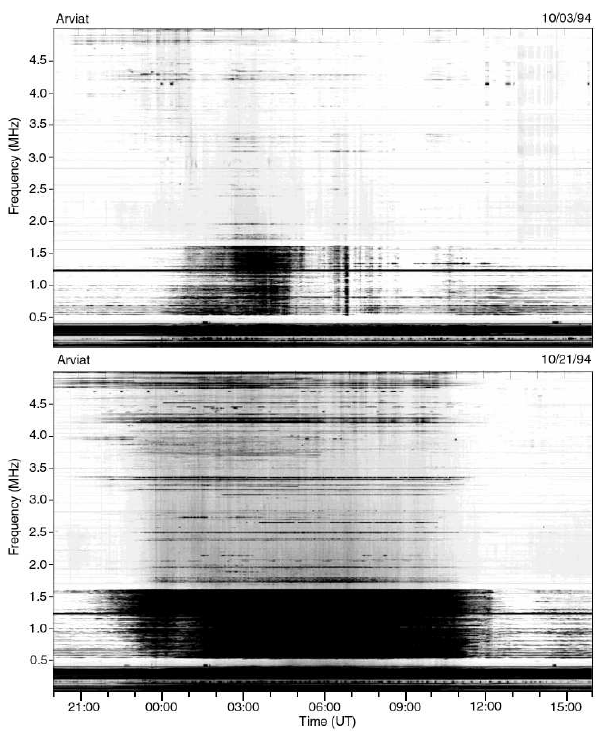
Fig. 2. 50–5000kHz spectrograms recorded at Arviat, Nunavut, on: (a) 3–4 October 1994, the most disturbed day of the month on which 6Kp =48; and (b) 21–22 October 1994, the geomagnet- ically quietest day of the month on which 6Kp =6. White (black) pixels represent psd below (above) 6 × 10 − 9 V/M √ ( Hz ) V/M